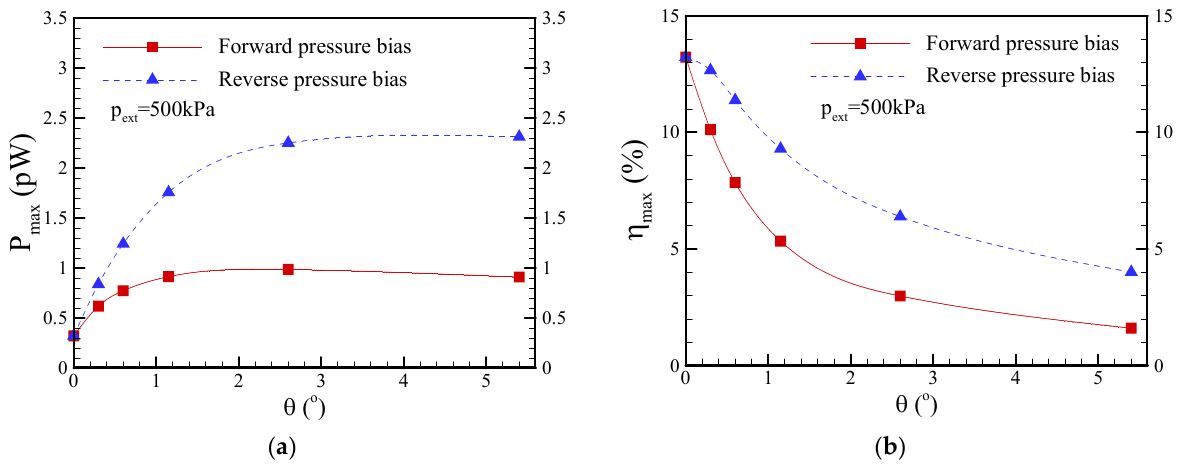
Figure 15. Plots of the ( a ) maximum power (P max ) and ( b ) maximum conversion efficiency ( η max ) as a function of the half-cone angle ( θ ) under the conditions of c 0 = 0.1 mM and p ext = 500 kPa. Note that σ s = −5 mC/m 2 and b = 20 nm. The half-cone angle was adjusted by changing the base radius a b .